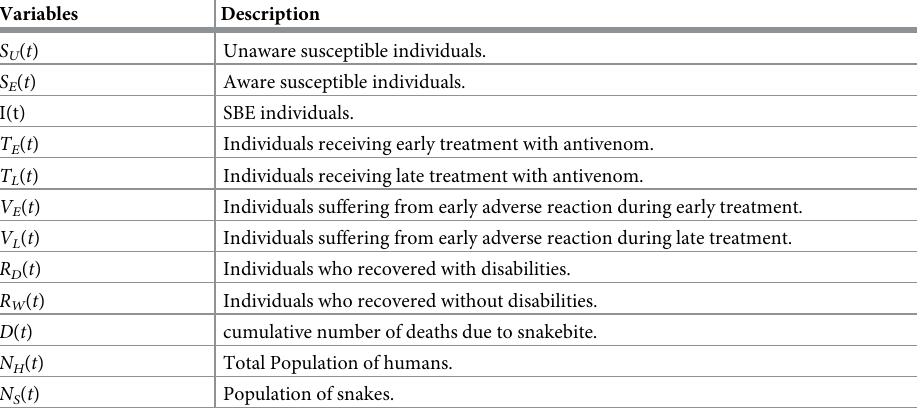
Table 1. Description of state variables of the